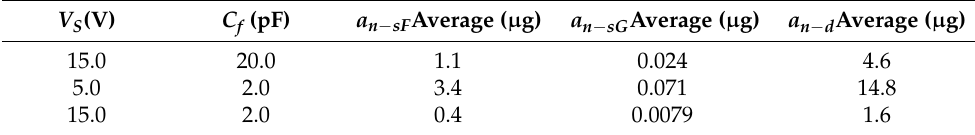
Table 8. Average value of a n for different values of V s and C f